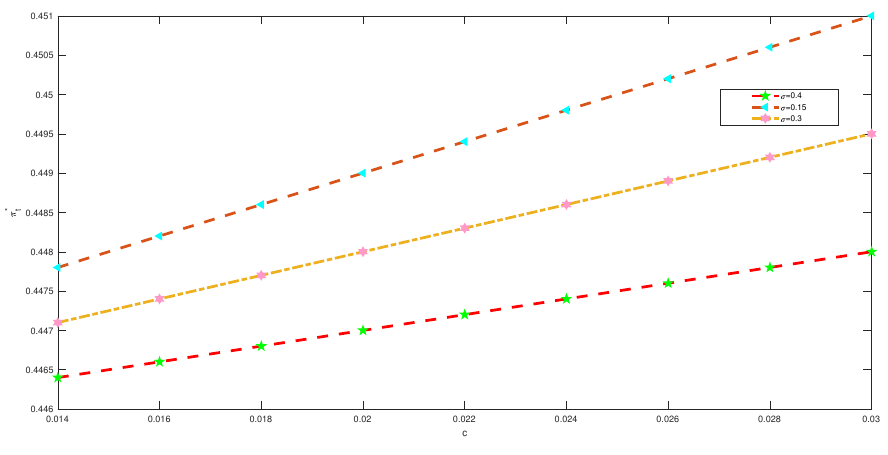
Figure 4. Effect of parameter c on π ∗